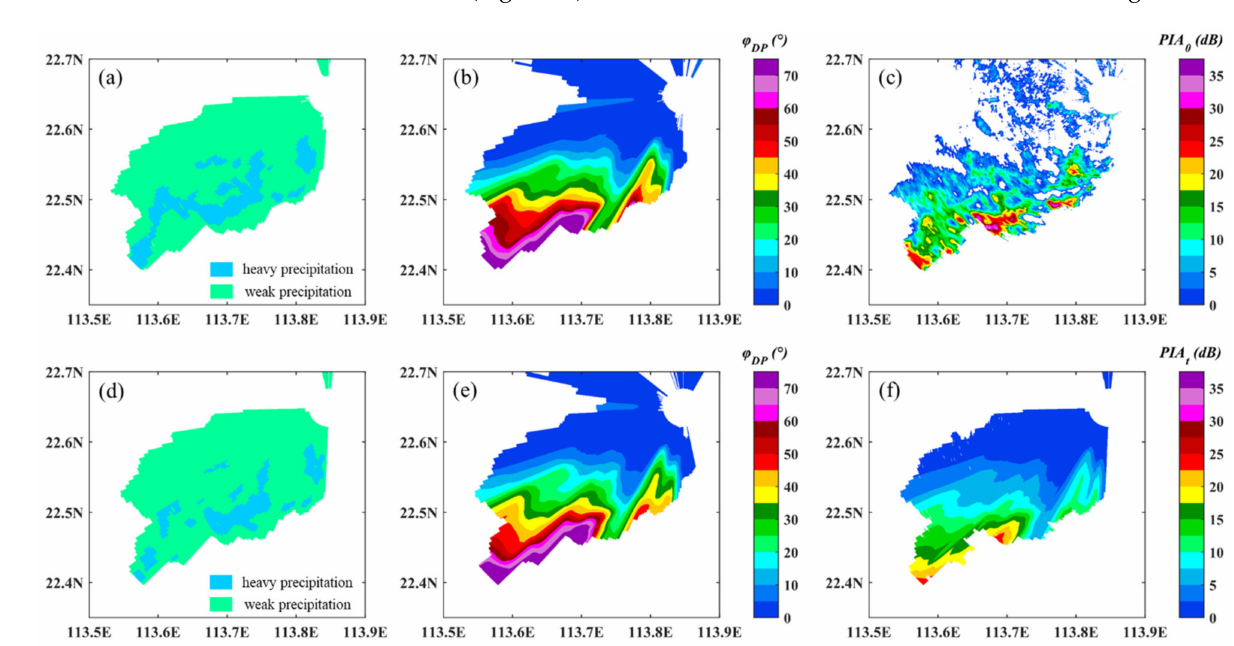
Figure 7. Precipitation classification ( a , d ), ϕ DP ( b , e ), and PIA ( c , f ) of X-PAR1 at 4.5 ◦ elevation-angle PPI from 01:44 to 01:50, where ( a – c ) are the calculation results at 01:44, ( d – f ) are the calculation results at 01:50, ( c ) is the PIA 0 calculated by Equation (16), and ( f ) is the PIA t calculated by attenuation- correction method proposed in this